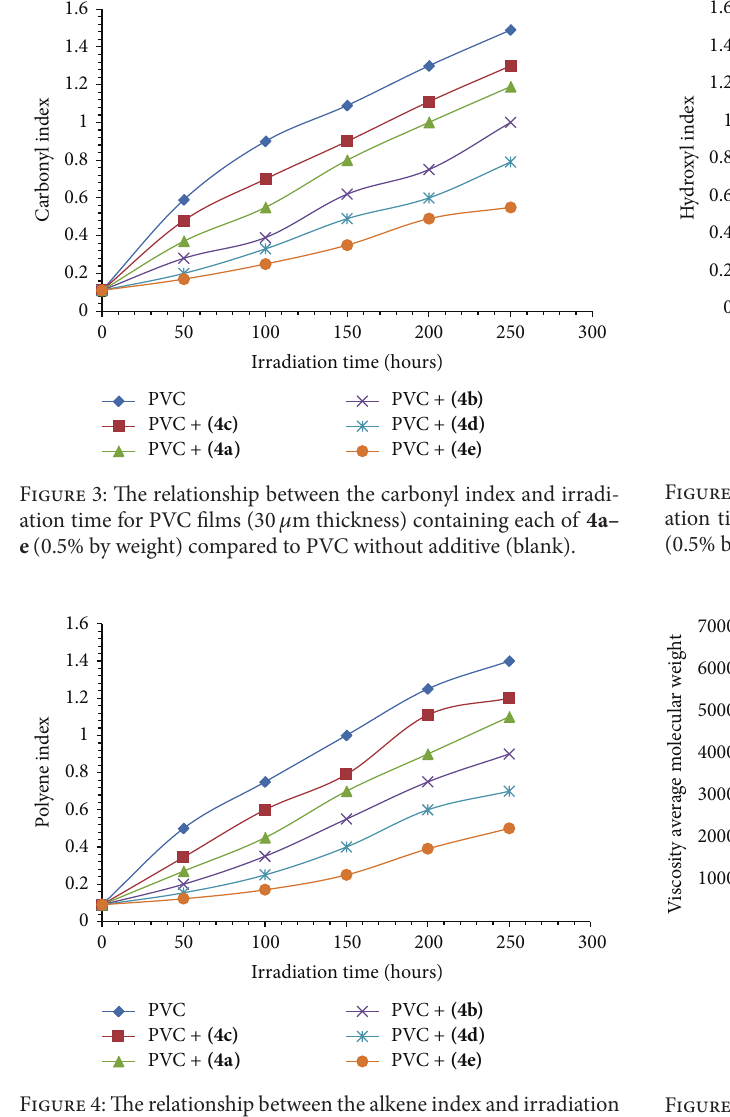
Figure 6: Changes in the viscosity-average molecular weight (𝑀 V ) during irradiation of PVC films (30 𝜇 m) with or without 4a–e (0.5% by